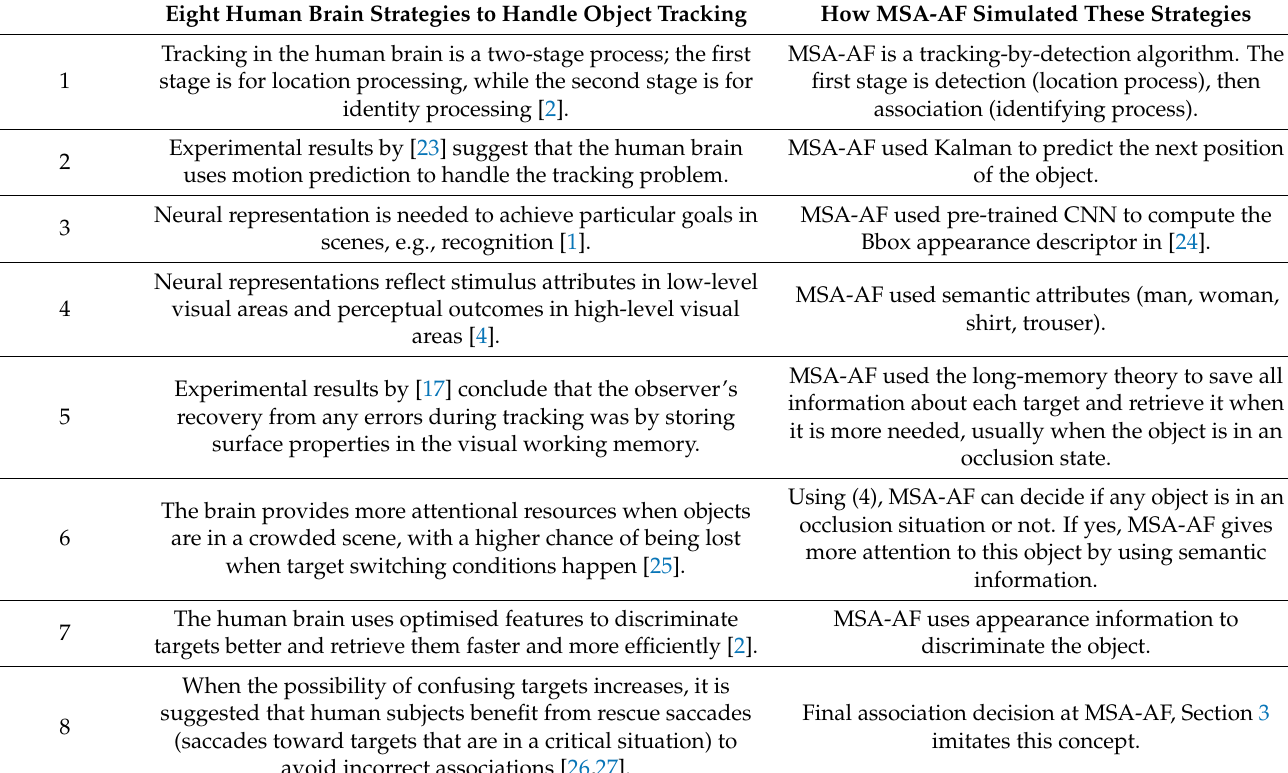
Table 2. Eight human brain strategies behind our